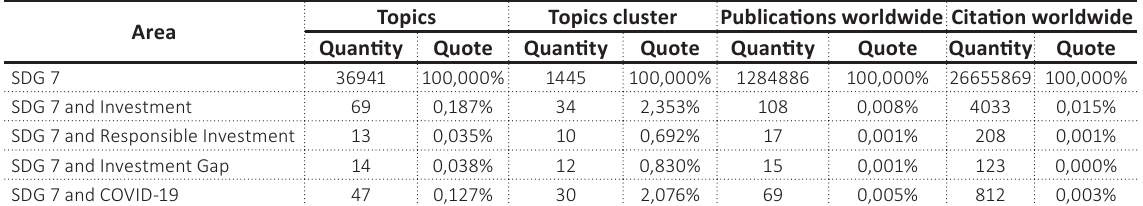
Table 2. State-of-the-art analysis of SDG 7 and investment research areas in 2010–2022 as of December 25,